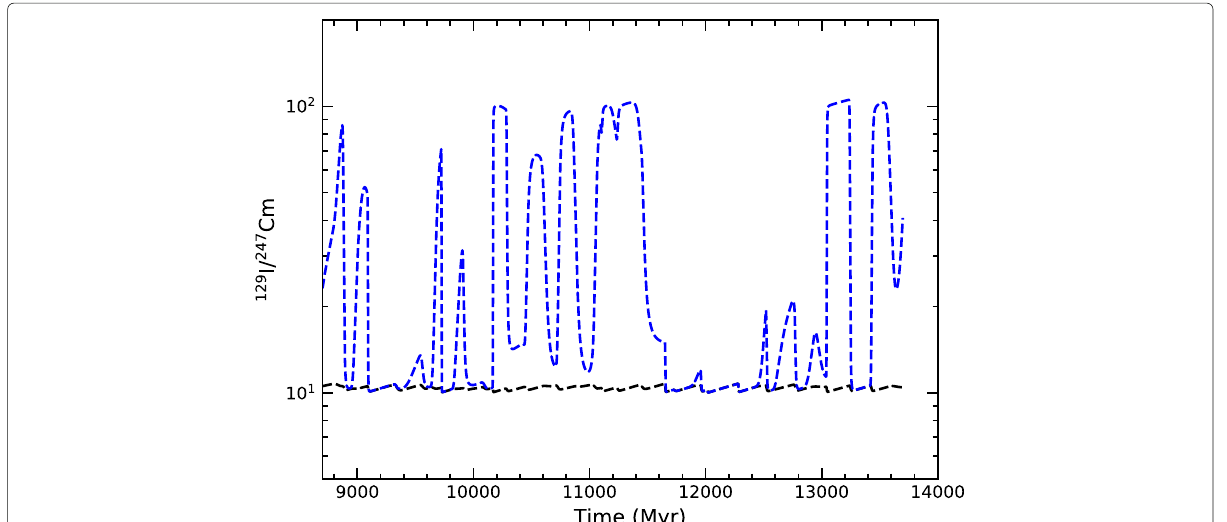
Fig. 7 Evolution of 129 I/ 247 Cm: One r -process source with 129 I/ 247 Cm production ratio of 10 is plotted in black. The case where there are two equally frequent sources with 129 I/ 247 Cm production ratios of 10 and 100, respectively, is shown in blue. In both cases the total rate of r -process events is 10 Myr −